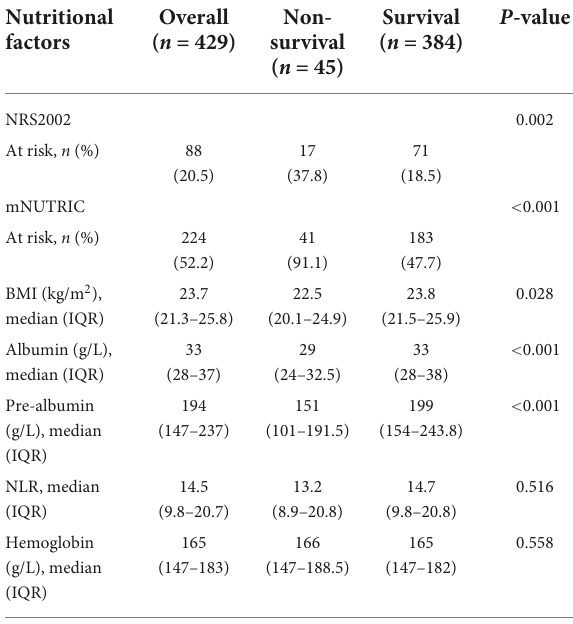
TABLE 2 Nutrition risk and laboratory nutritional parameters ( N = 429).